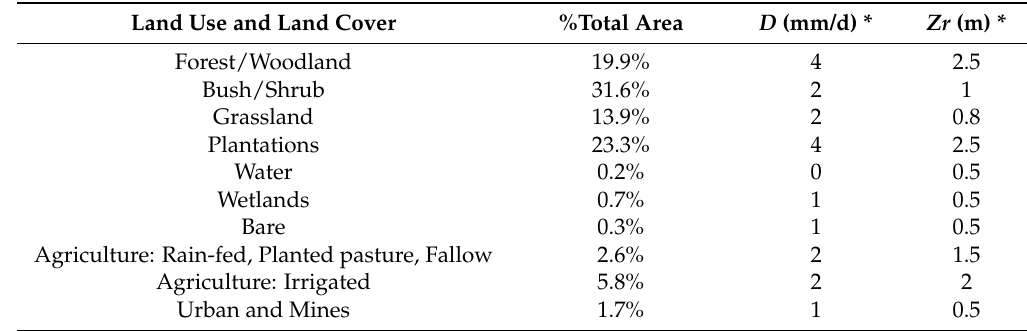
Table 2. Final model parameters dependent on land use and land cover